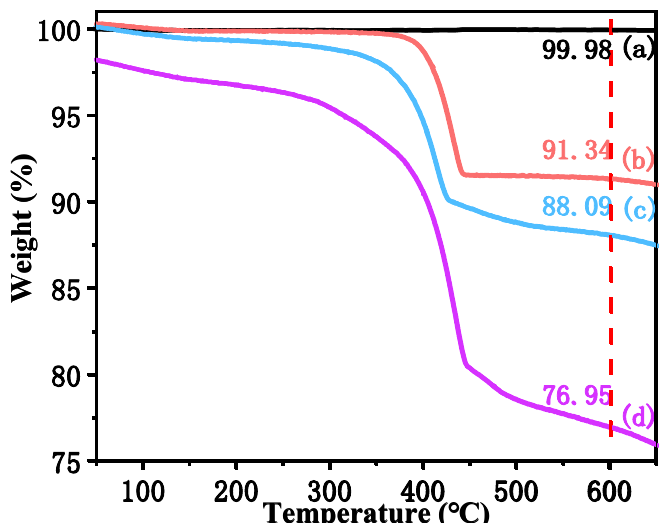
Figure 4. The thermogravimetric curves for ( a ) untreated CSWs, ( b ) CSW-OH, ( c ) CSW-OH-KH570, and ( d ) CSW-g-PMMA. and ( d )